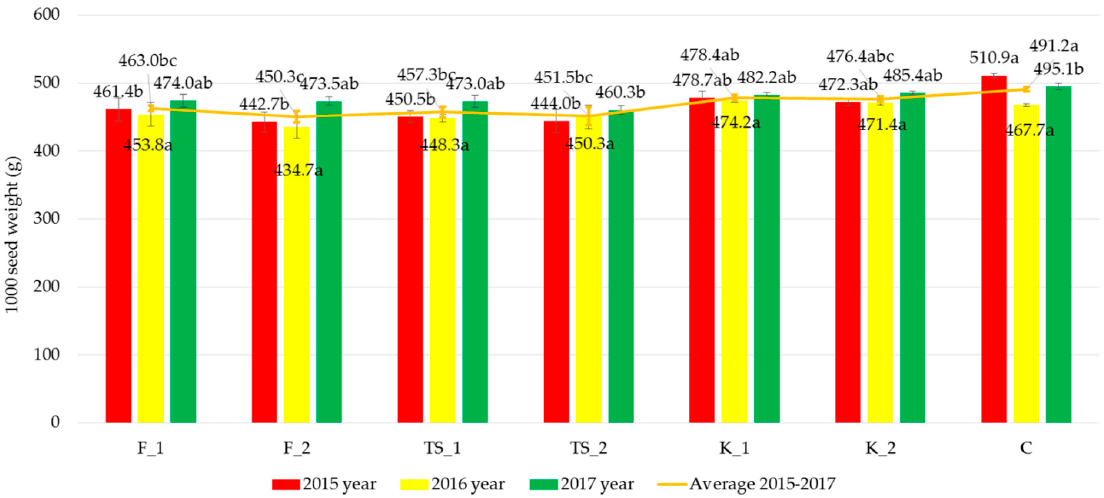
Figure 2. E ff ect of Fylloton, Terra Sorb Complex, and Kelpak biostimulant treatment on the weight of one thousand seeds of bean variety Oczko. Abbreviations: F_1, single spraying of Fylloton; F_2, double spraying of Fylloton; TS_1, single spraying of Terra Sorb Complex; TS_2, double spraying of Terra Sorb Complex; K_1, single spraying of Kelpak; K_2, double spraying of Kelpak; C, control. Means over the study years followed by di ff erent small letters are significantly di ff erent at p < 0.05. Table 5. E ff ect of Fylloton, Terra Sorb Complex, and Kelpak biostimulant treatment on protein, phenol, and flavonoid content of bean